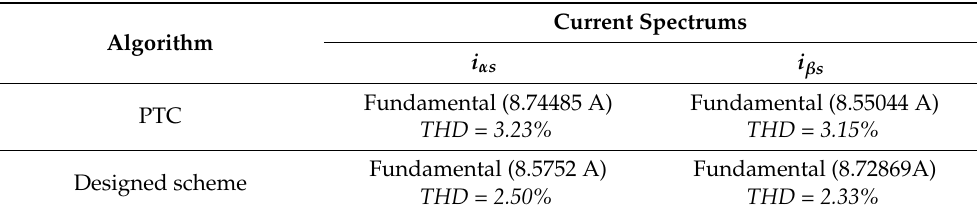
Table 1. Spectrums of currents under PTC and PVC techniques.